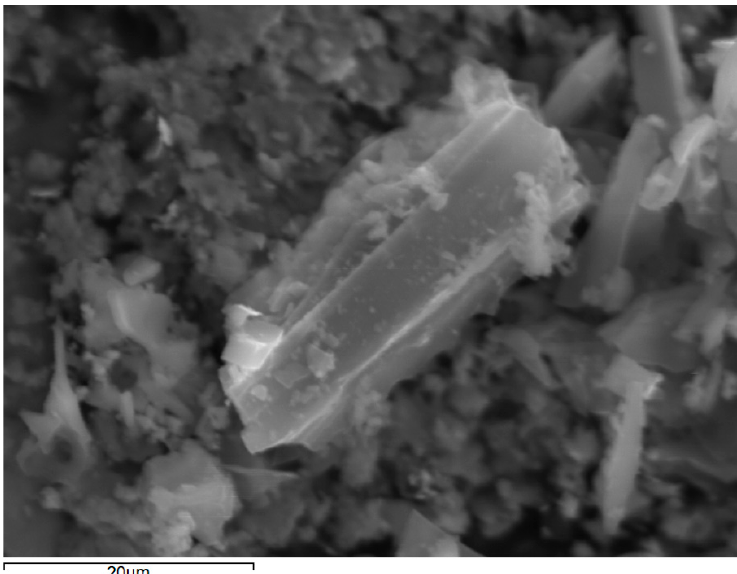
Figure 1. Representative SEM image of the biochar showing deposits of minerals. The formation of carbonate species may either be due to pyrolysis or, more likely, the exposure of BC in the air and the subsequent reaction of CaO with CO 2 . Based on EDX analysis, the percent elemental composition was as follows: 86.5% C, 12.2% O, 0.5% Ca, 0.3% K, 0.2% Mg, and 0.1% from each of P, Si, and Cl. Minerals were in the form of oxides and carbonates, since only small amounts of Cl were detected.